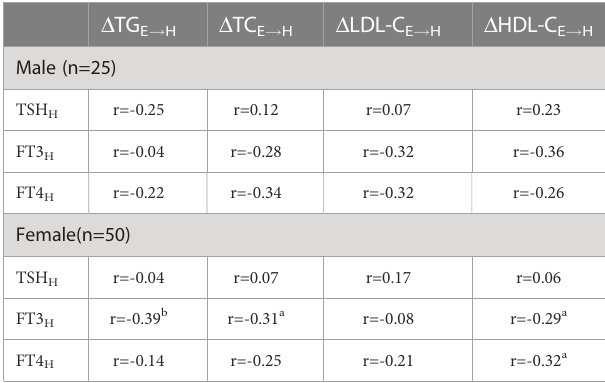
TABLE 4 Correlation between thyroid function in the hypothyroid state and changes in serum